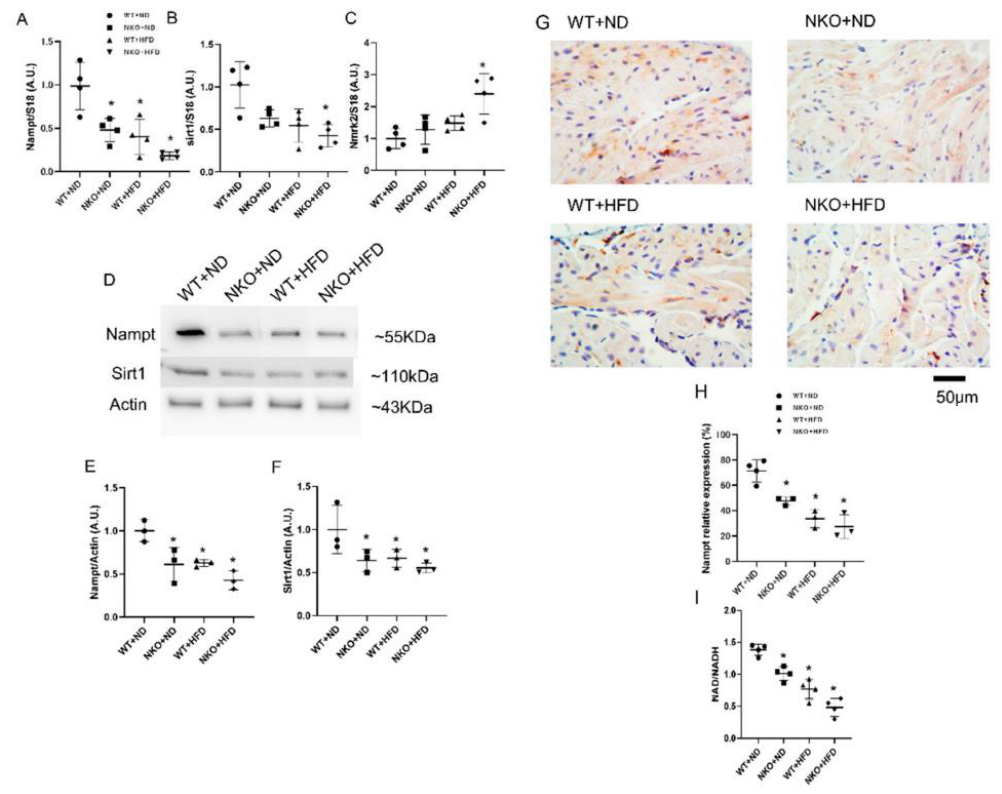
Figure 1. Gene and protein expressions of Nampt and Sirt1 in the atrial tissues. ( A ) Nampt mRNA expression levels in the atrial tissues evaluated by quantitative PCR ( n = 4 mice per each group). ( B ) Sirt1 mRNA expression levels in the atrial tissues evaluated by quantitative PCR ( n = 4 mice per group). ( C ) Nmrk2 mRNA expression levels in the atrial tissues evaluated by quantitative PCR ( n = 4 mice per group). ( D ) Representative western blots for Nampt and Sirt1 in the atrial tissues ( n = 3 mice per group). ( E ) Nampt protein expression levels in the atrial tissues ( n = 3 mice per group). ( F ) Sirt1 protein expression levels in the atrial tissues ( n = 3 mice per group). ( G ) Representative images of Nampt immunohistochemistry in the atrial tissues. Nampt was mainly expressed in the cytoplasm of atrial cardiomyocytes. Scale bar: 50 µm. ( H ) Positively stained areas in the atrial tissues by immunohistochemistry. ( I ) Atrial NAD/NADH ratio in four studied groups ( n = 4 mice per group). * p < 0.05 vs. WT+ND mice. Data are shown as mean ± SD. Statistical comparisons between multiple groups: one-way ANOVA followed by a post hoc Bonferroni test.